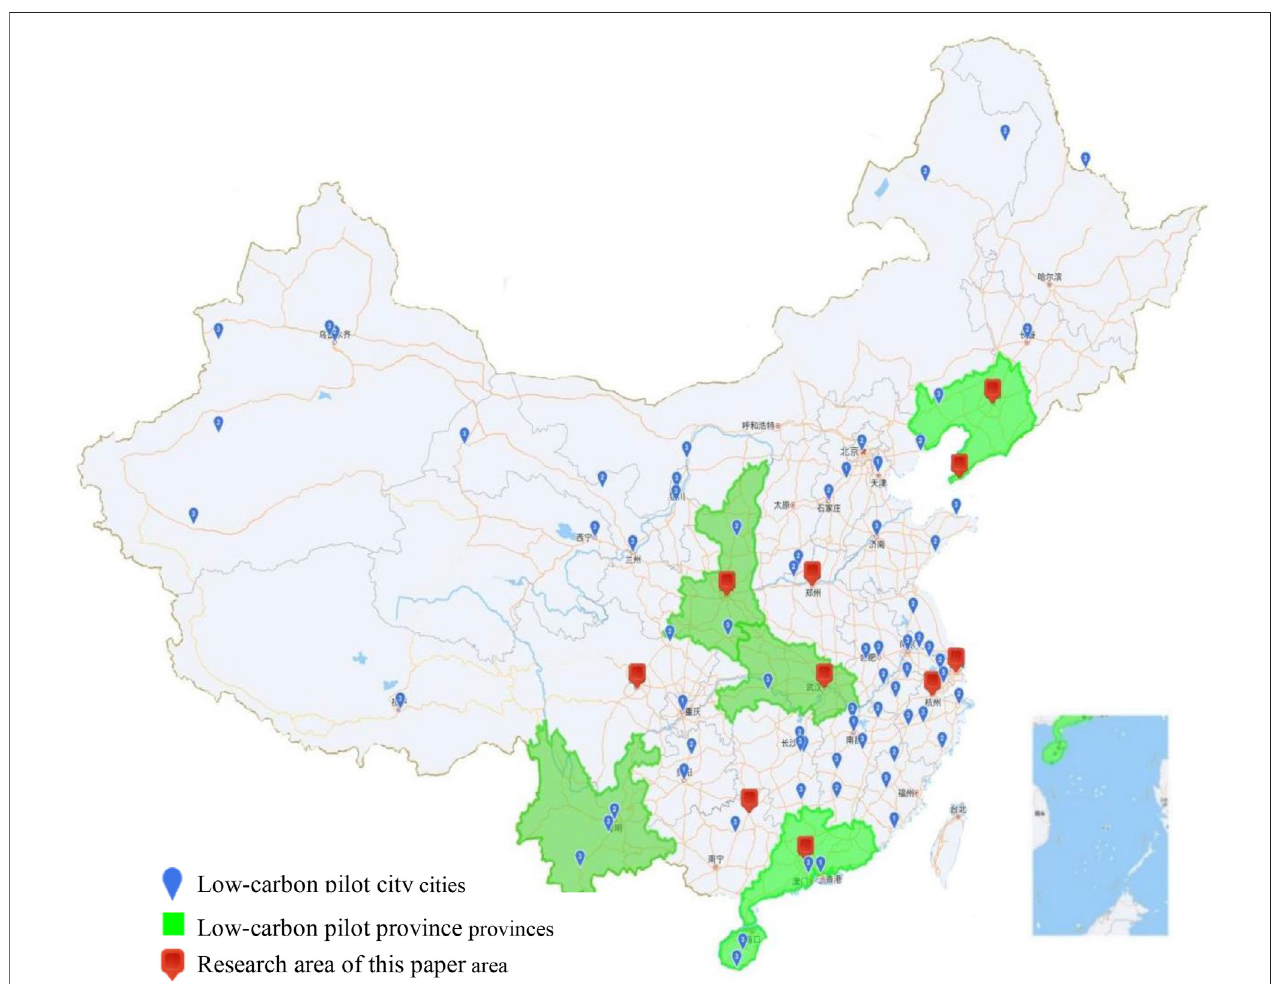
FIGURE 3 | Distribution of low-carbon pilot